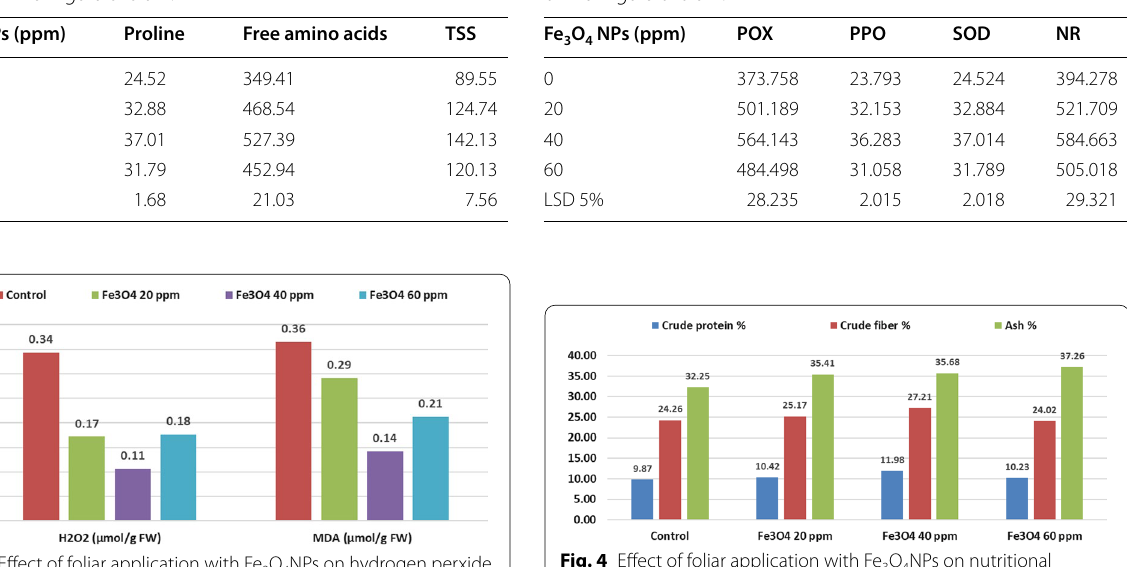
O NPs on antioxidant 3 4 /g FW/h) 2